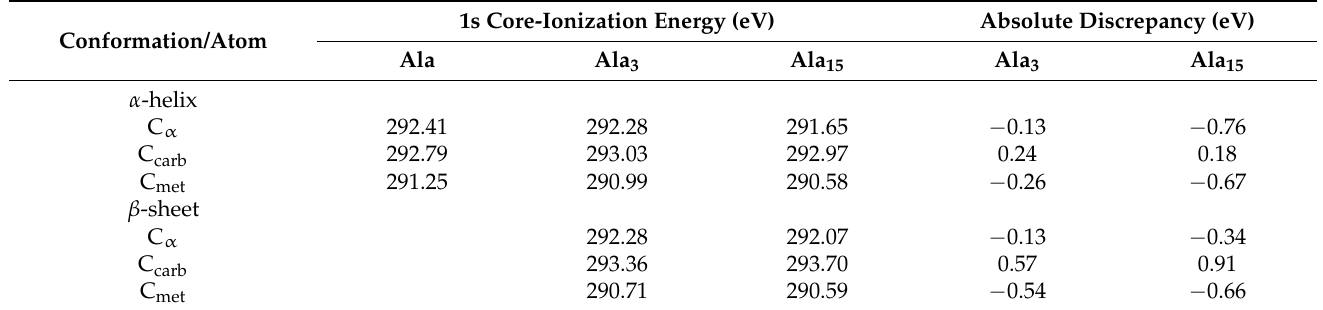
Table 4. 1s core-ionization energies obtained for carbon atoms C α , C carb , and C met in the isolated alanine amino acid (fully IMOM calculations), in residue Ala2 of polypeptide Ala 3